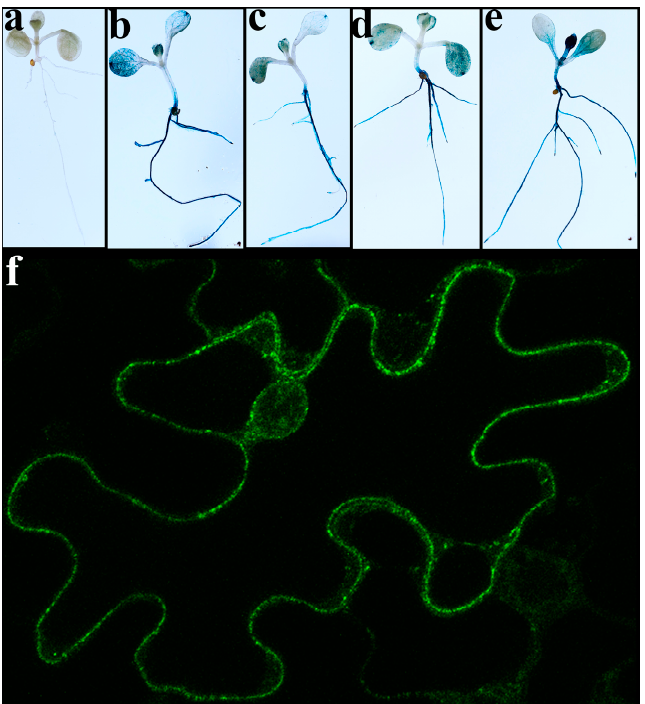
Figure 1. Expression of C-terminal fusion proteins Esi0017_0056-GUS and Esi0017_0056-GFP . ( a – e ) GUS expression in A. thaliana 5 days old plantlets ( a ) WT and ( b – e ) independent transgenic lines. ( f ) GFP expression in N. benthamiana leaf.